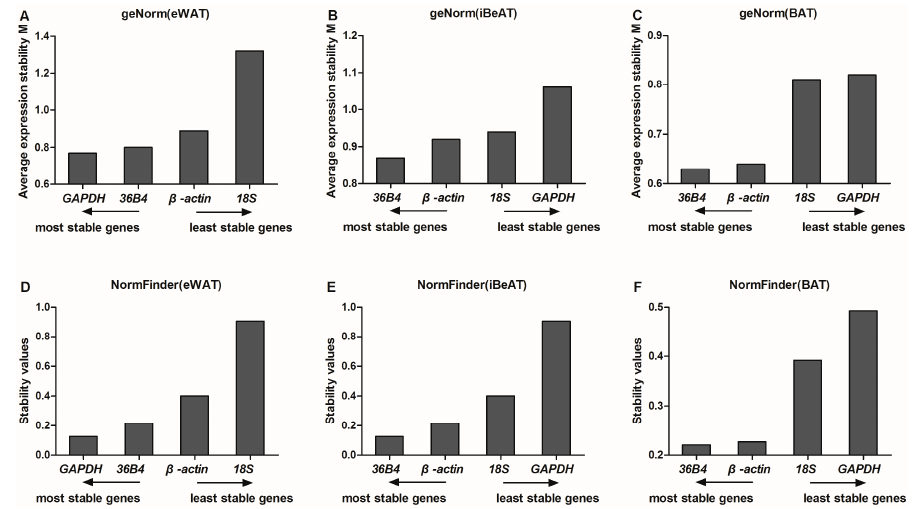
Figure 3. Expression stability values and ranking of the reference genes in different types of adipose tissue by geNorm and NormFinder ( n = 12). ( A – C ) gene expression stability values (M) in epididymal white adipose tissue (eWAT), inguinal beige adipose tissues (iBeAT) and brown adipose tissue (BAT) by geNorm; ( D – F ) gene expression stability values in eWAT, iBeAT and BAT by NormFinder. GAPDH : Glyceraldehyde-3-phosphate dehydrogenase; 36B4 : acidic ribosomal phosphoprotein P0.